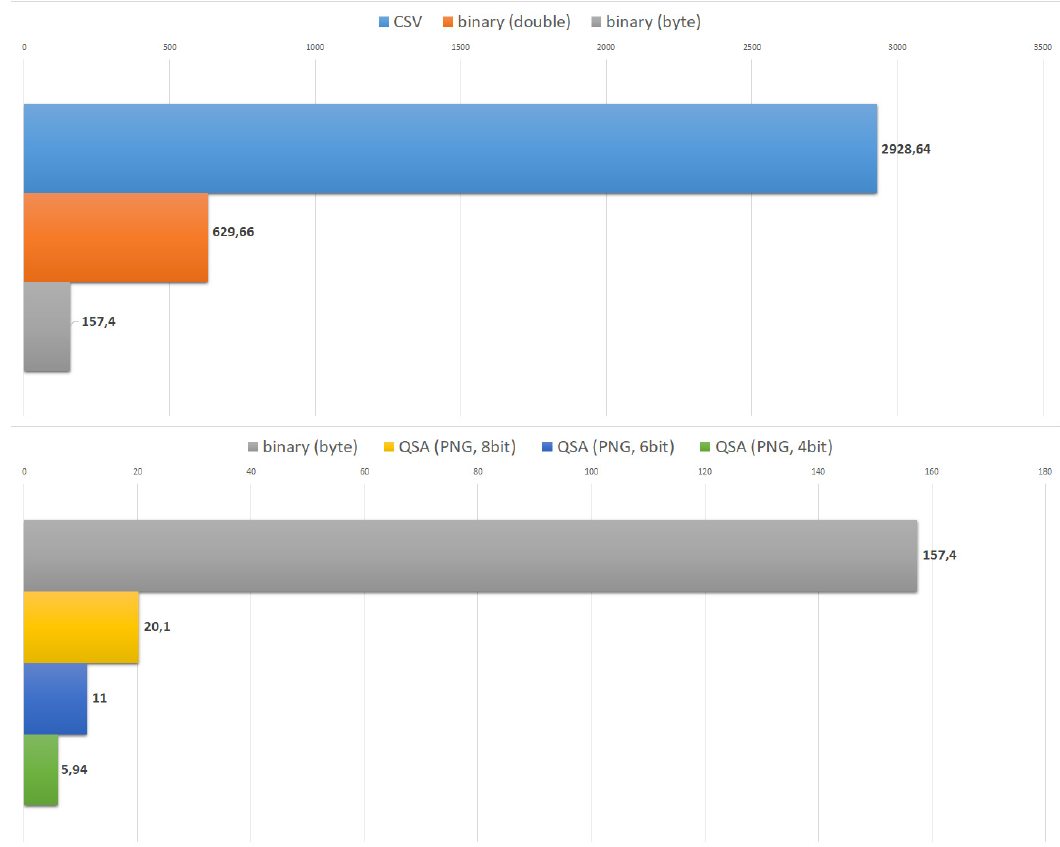
Figure 7. Top: data size comparison (Kb) between original dataset (CSV) and binary (double and